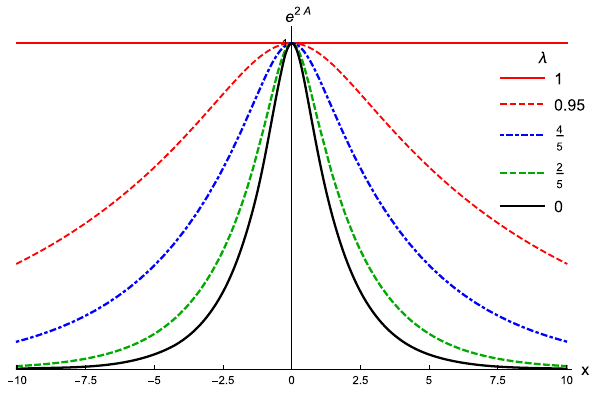
Fig. 11 The energy density for some values of λ . Here we see how it becomes delocalized as λ → 1. For λ = 1, there is no more energy concentration around the origin and the brane disappears from the back- ground geometry